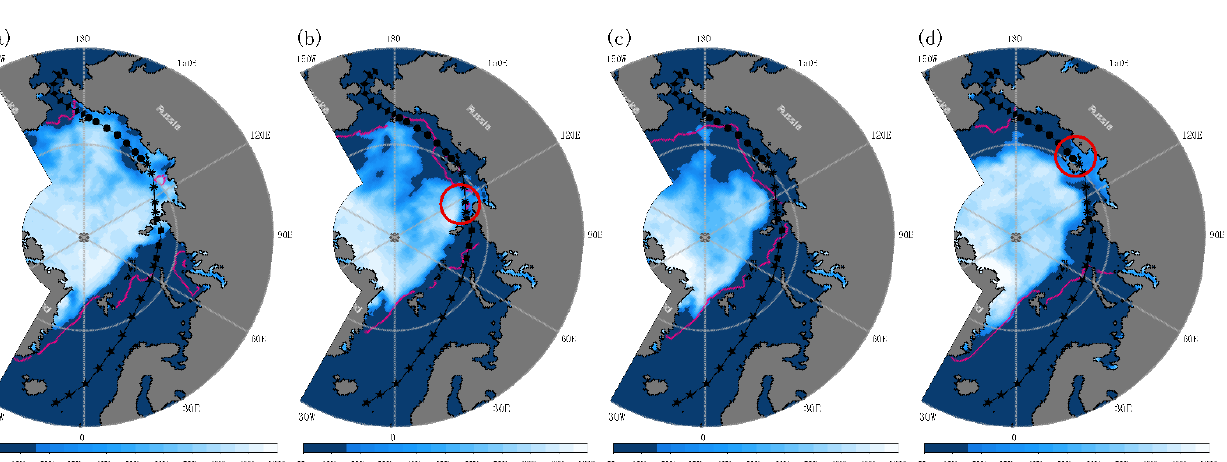
Figure 4. Histogram of monthly average sea ice extent in Arctic summer for 2016, 2019, 2020 and multi-year average. (The green dashed line is the fitting trend line of the sea ice extent in the summer of 2016, the purple dashed line is the summer of 2019, the red dashed line is the summer of 2020, and the black dashed line is the multi-year average).